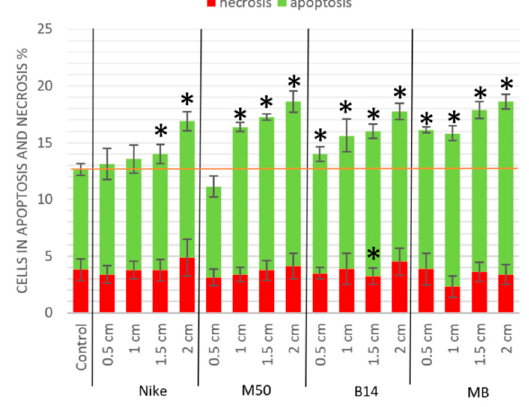
Figure 5. Apoptosis of the THP-1 cells after 48 h of incubation with the tested linen fabrics on four different surfaces (0.5, 1.0, 1.5 and 2.0 cm). The results are presented as the percentage of apoptotic cells. The results are the means of 5 independent experiments. The statistical significance of the differences between the results for the tested linen fabric compared to the control was calculated using Tukey’s post hoc test (* p < 0.05).